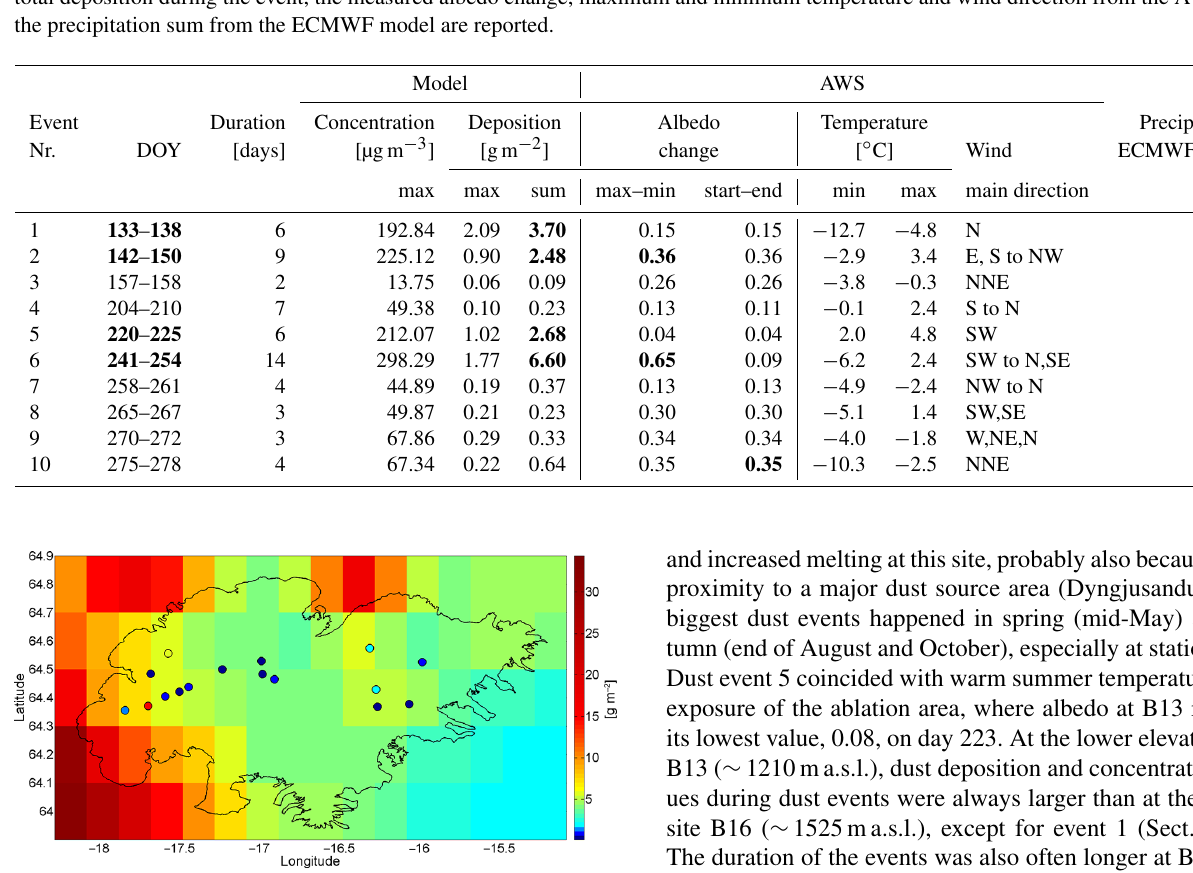
Figure 2. FLEXPART model simulation of the spatial dust distri- bution on Vatnajökull from 1 January to 7 October 2013, the day when the surface snow samples have been taken. The circles show the location of snow sample sites with dust deposition for the same